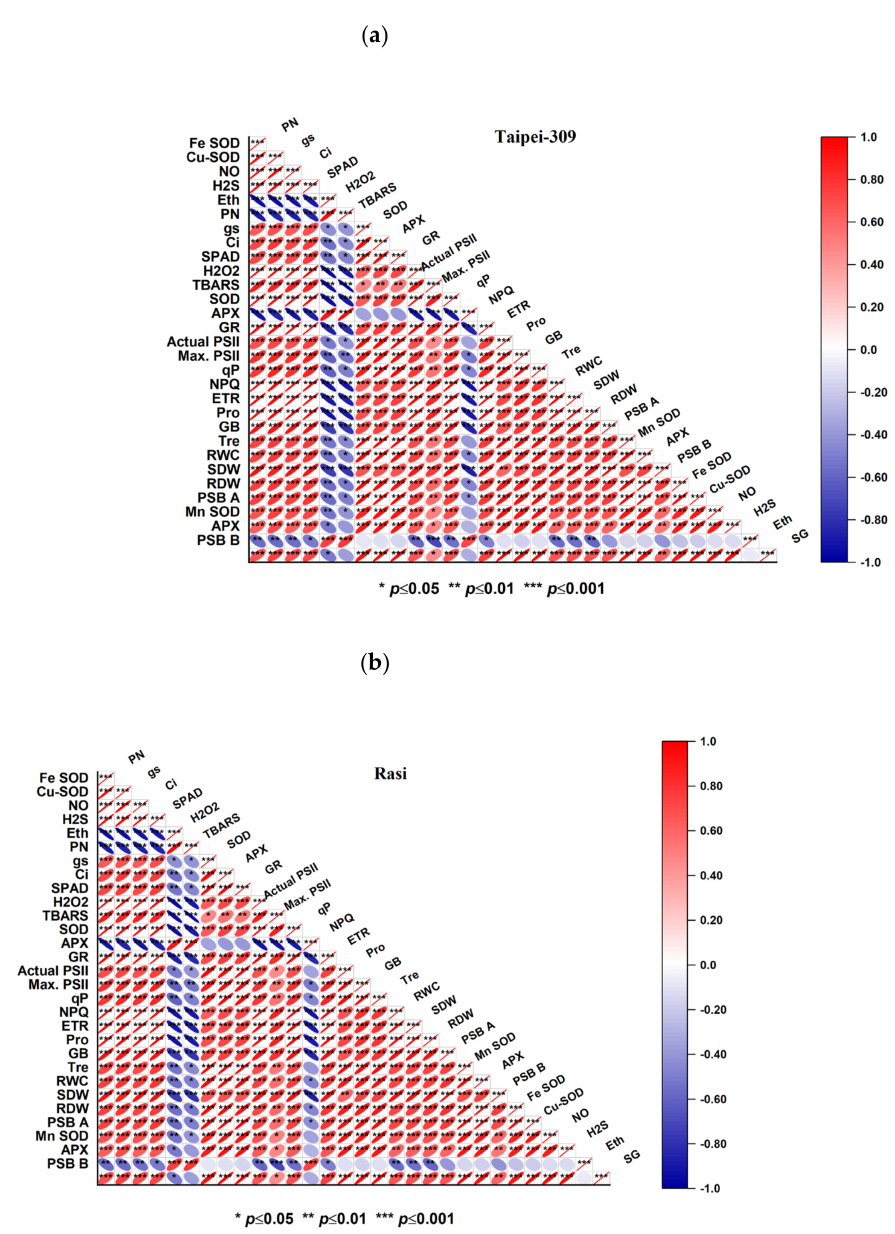
Figure 7. Pearson correlation represents the relationship among different variables of two rice cultivars, Taipei-309 ( a ) and Rasi ( b ) grown under different conditions such as control, high temperature stress; HS (T1), Eth; Eth (T2), sodium nitroprusside; SNP (T3), sodium hydrosulfide; NaHS (T4), HS + Eth (T5), HS + SNP (T6), HS + NaHS (T7), HS + Eth + hypotaurine; HT (T8), HS + SNP + HT (T9), HS + NaHS + norbornadiene; NBD (T10) and HS + NaHS + 2-4-carboxyphenyl-4,4,5,5- tetramethylimidazoline-1-oxyl-3-oxide; cPTIO (T11). The variables included H 2 O 2 (hydrogen perox- ide), TBARS (thiobarbituric acid reactive substances), non-photochemical quenching (NPQ), ethylene evolution, SOD (superoxide dismutase), APX (ascorbate peroxidase), GR (glutathione reductase) activity, gene expression of ( Mn-SOD , Cu-SOD , Fe-SOD , and APX ), contents of H 2 S (hydrogen sul- fide), NO (nitric oxide), proline, Tre (trehalose), SG (soluble sugar) and GB (glycine betaine), gene expression of psbA and psbB , Pn (net photosynthesis), Gs (stomatal conductance), Ci (intercellular CO 2 concentration), SPAD value, maximum efficiency of PSII, actual efficiency of PSII, qP (photochemical quenching), NPQ (non-photochemical quenching), ETR (electron transport rate), RDW (root dry weight), SDW (shoot dry weight), and RWC (relative water